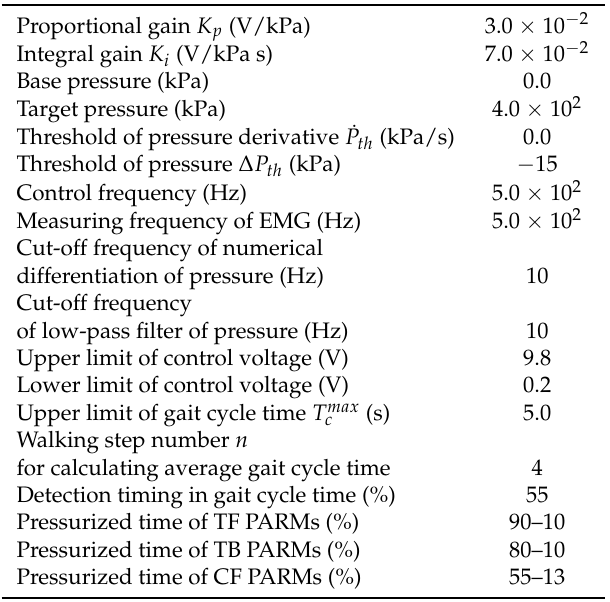
Table 2. Given parameters for the proposed control